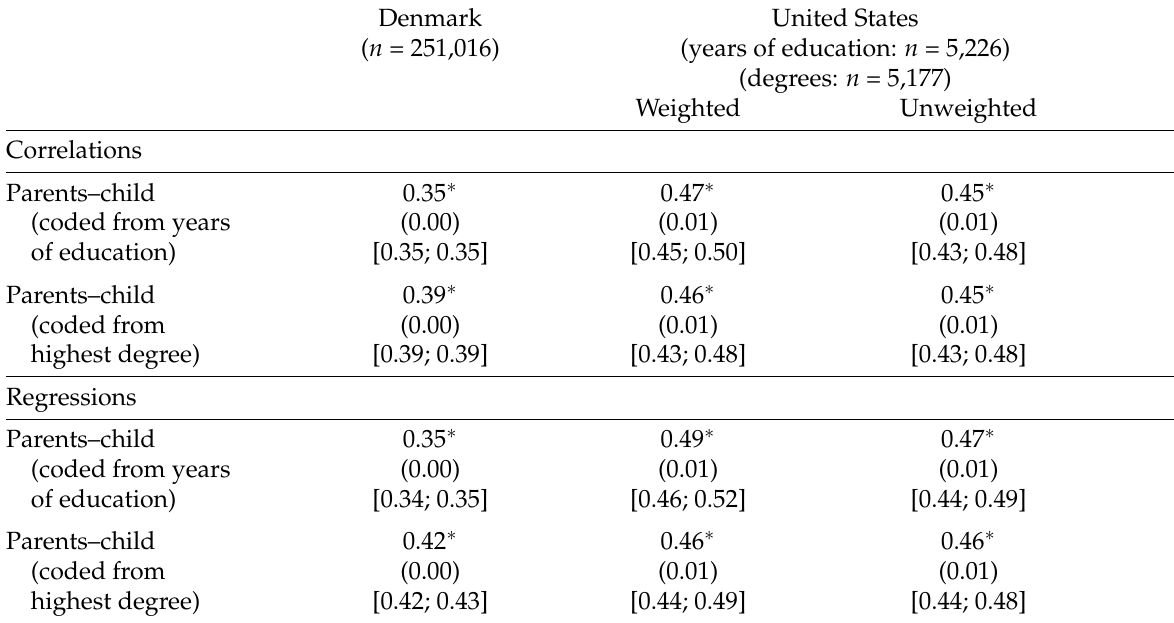
Table 2: Educational mobility by continuous measures: children’s years of education (2013) by parents’ years of education (maximum of parents’